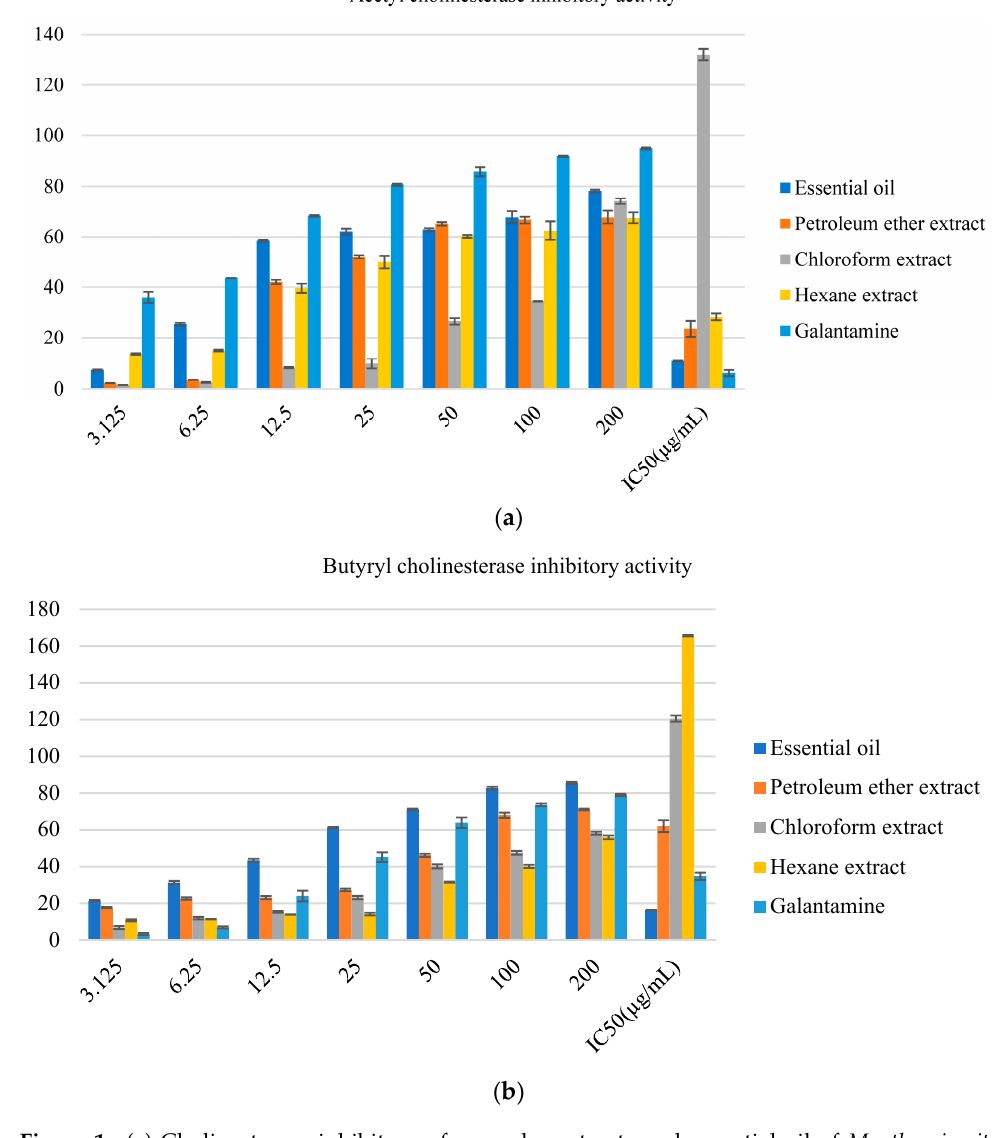
Figure 1. ( a ) Cholinesterase inhibitory of nonpolar extracts and essential oil of Mentha piperita. ( b ) Cholinesterase inhibitory of nonpolar extracts and essential oil of Mentha piperita. Table 2. Docking scores of galantamine and major compounds from Mentha piperita with both AChE and